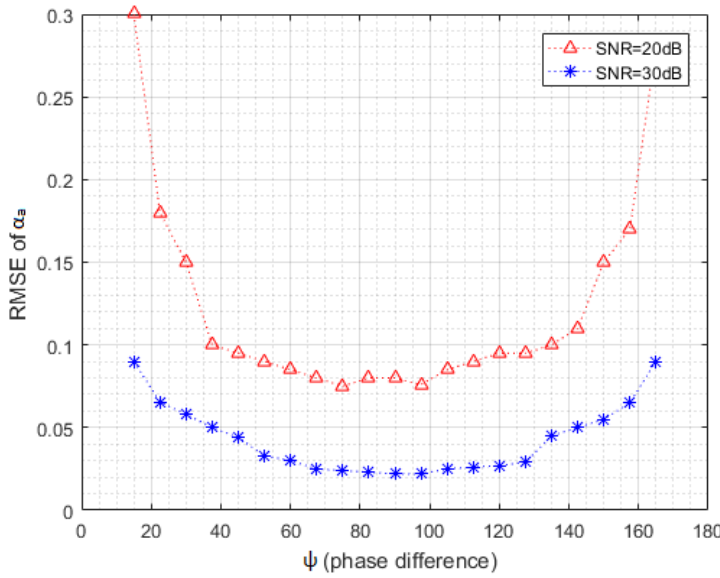
Figure 7. RMSE of α a versus ψ for SNR = 30 dB and SNR = 20 dB ( Δφ = 0.7°) . Figure 8 represents the RMSE of α a ; in this case, Δ φ = φ a − φ b varies from 0.2° to 6° (when φ a gets closer to φ b , the performance will become worse). We can see that the algo- rithm has a better performance when Δ φ increases ( Δφ is proportional to Δβ = β b − β a ).